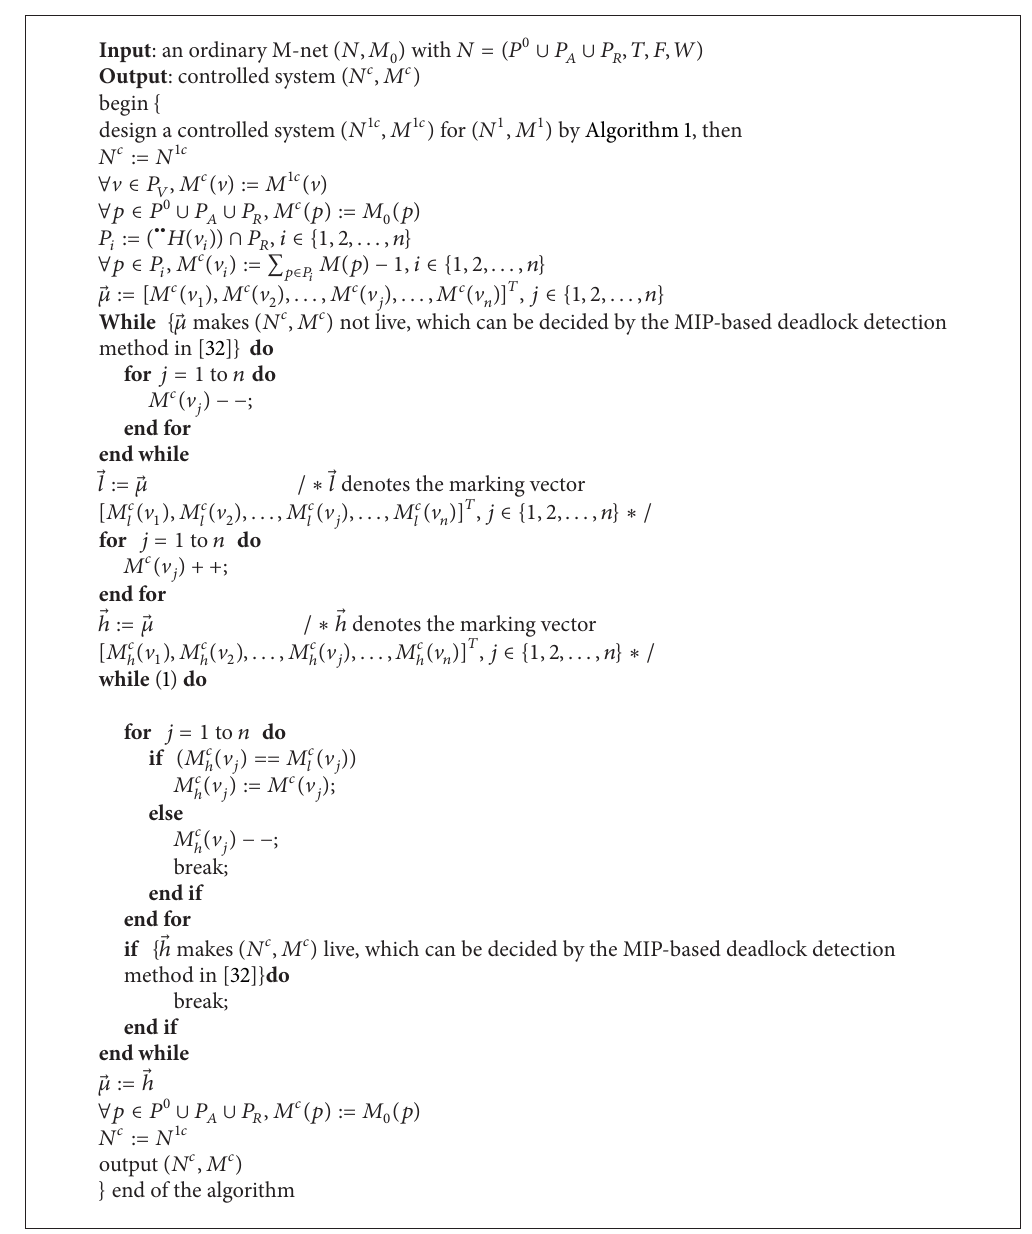
Algorithm 2: Controlled system design for (𝑁,𝑀 0 )